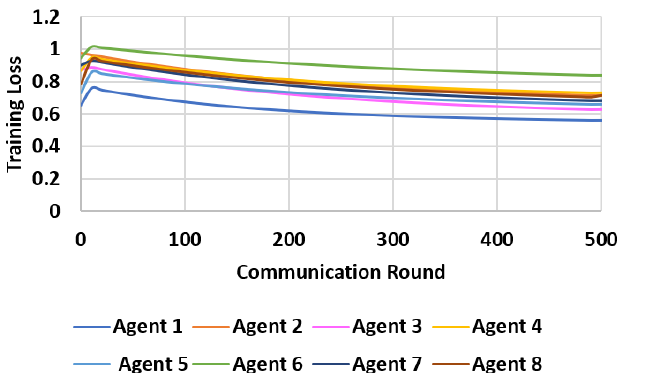
Figure 23. FedResilience’s impact on participating FL agents’ (eight agents and six stragglers) model loss for the prediction of CIA outages.